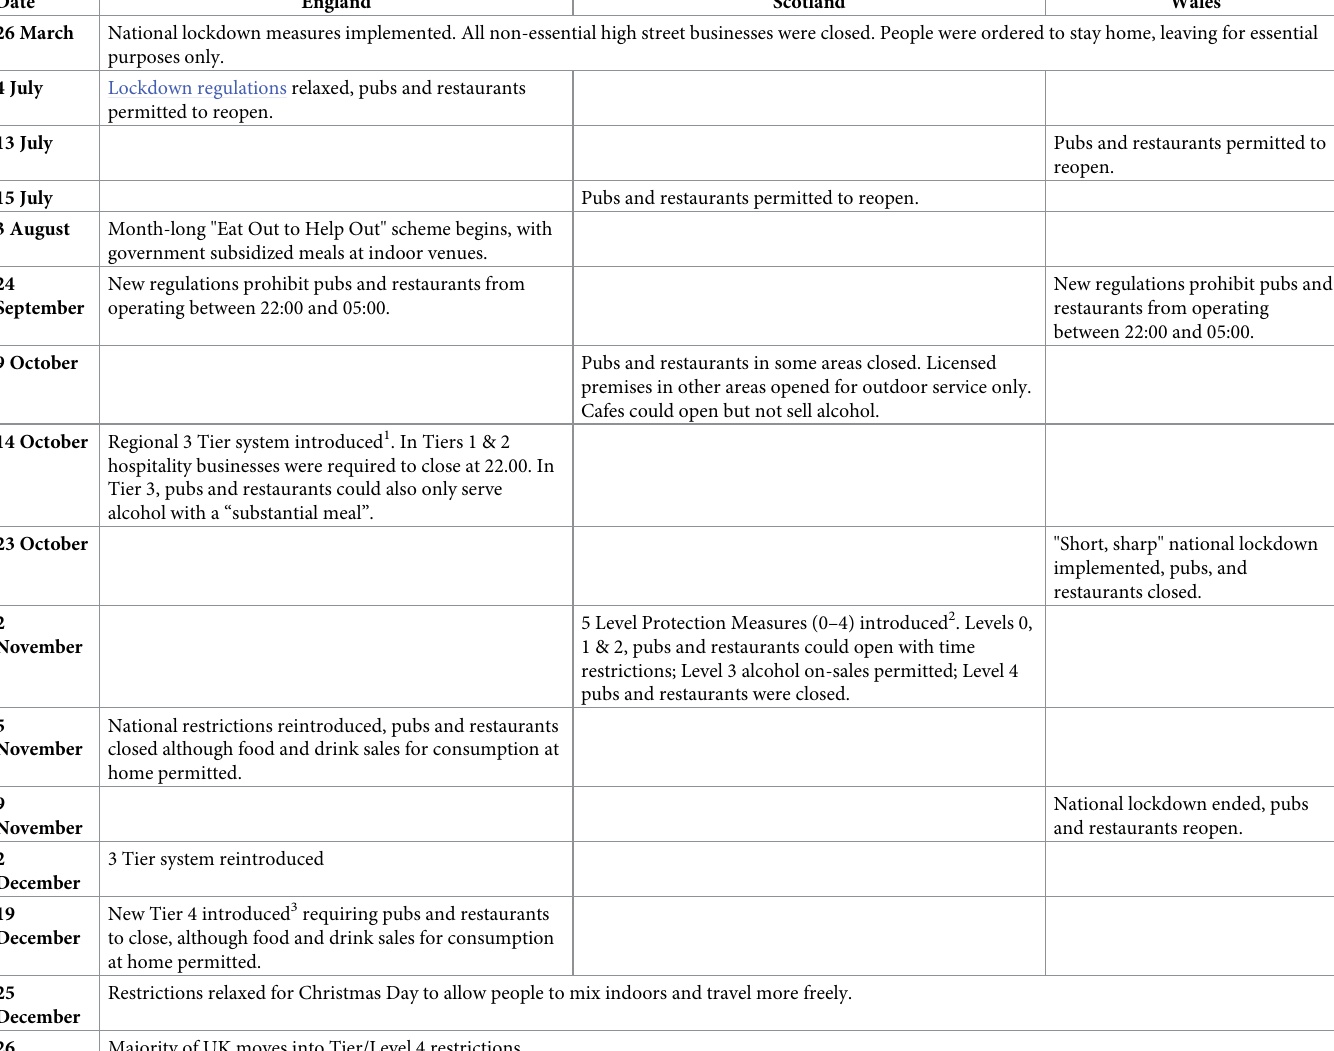
Table 1. COVID-19 lockdown regulations affecting the on-trade in England, Scotland, and Wales during